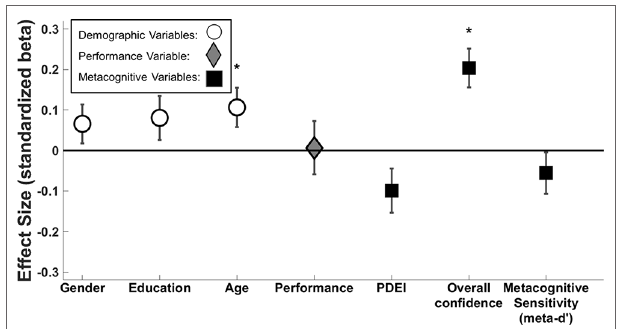
FIGURE 5 | Standardized beta coefficients ( ± standard error) of predictors of self-esteem score. White circle markers indicate demographic variables, the grey diamond indicates performance (d’ across both tasks) and black squares indicate metacognitive variables. We demonstrate significant effects of age ( β = . 106, p = .028) and overall confidence ( β = . 203, p = < .001). *p < .05.